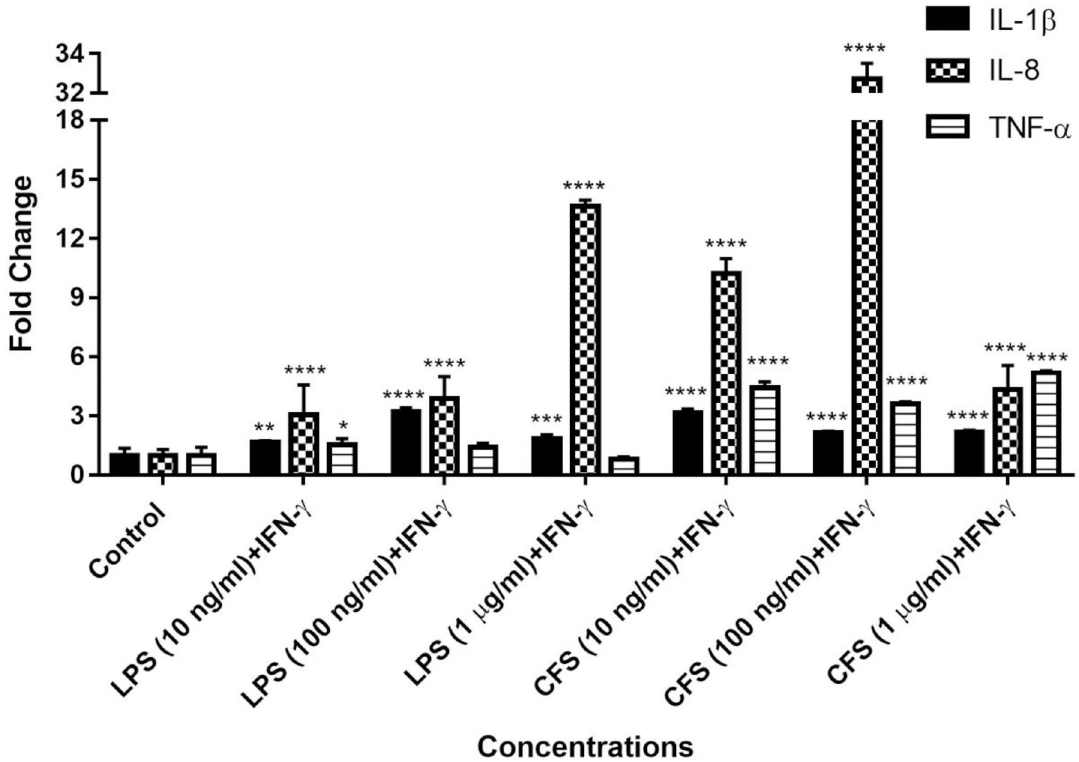
Fig 2. RT-PCR analysis for gene expression levels of IL-1 β , TNF- α and IL-8 of HMC3 cells. The data represents the means ± SDs of three individual experiments (n = 3 for each). One-way ANOVA was used for statistical analysis for each group, followed by a post hoc Tukey’s multiple comparisons test. All of the results are displayed on a single graph. no difference: p > 0.05; significant difference: � p < 0.05, �� p < 0.01, ��� p < 0.001, ���� p < 0.0001 vs. untreated controls.